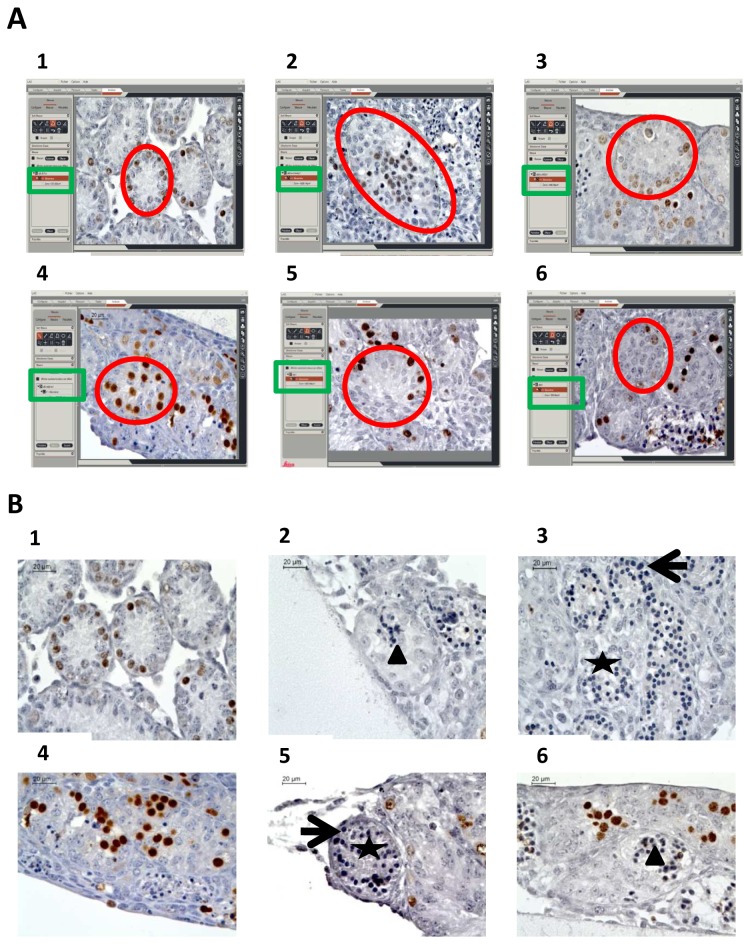
Seminiferous tubule growth (A) and intra-tubular necrosis (B) during organotypic culture of prepubertal mice testes under the different culture conditions assessed.(A) Seminiferous tubule area was defined using software (red circle) and area was automatically generated (green rectangle). (B) The percentage of partially (arrow head) or totally (star) necrotic seminiferous tubules were assessed as well as number of pyknotic nuclei (head).
(1-2-3) Organotypic culture of fresh immature mice testicular tissue after 0 (1) or 11 (2 and 3) days of culture with RE6 (2) or RERA5 (3)
(4-5-6) Organotypic culture of frozen-thawed testicular tissue with stabilisation phase at –8°C (5) and -9°C (6) compared to fresh control organotypic culture (4)Footnotes:
RE6: 10-6M retinol ; RERA5: 10-5M retinoic acid and 3.3.10-7M retinol